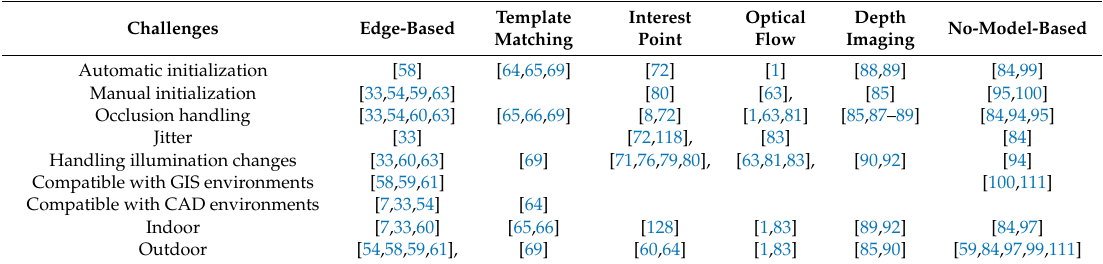
Table 3. Challenges in vision-based